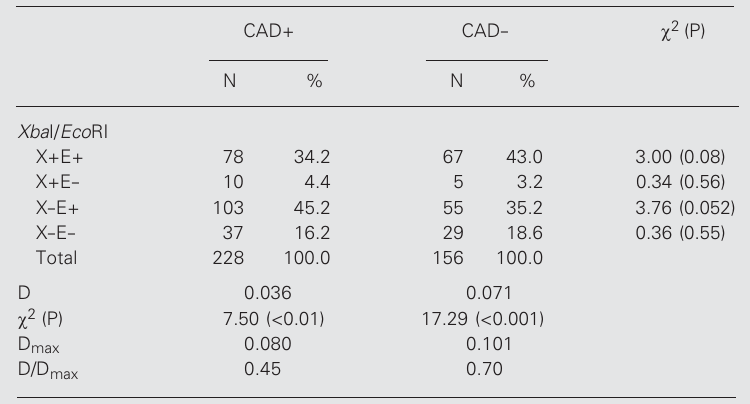
Table 3. Absolute and relative frequencies of the apo B ( Xba I/ Eco RI) haplotypes and results of linkage disequilibrium analyses in the CAD+ and CAD- groups. CAD+